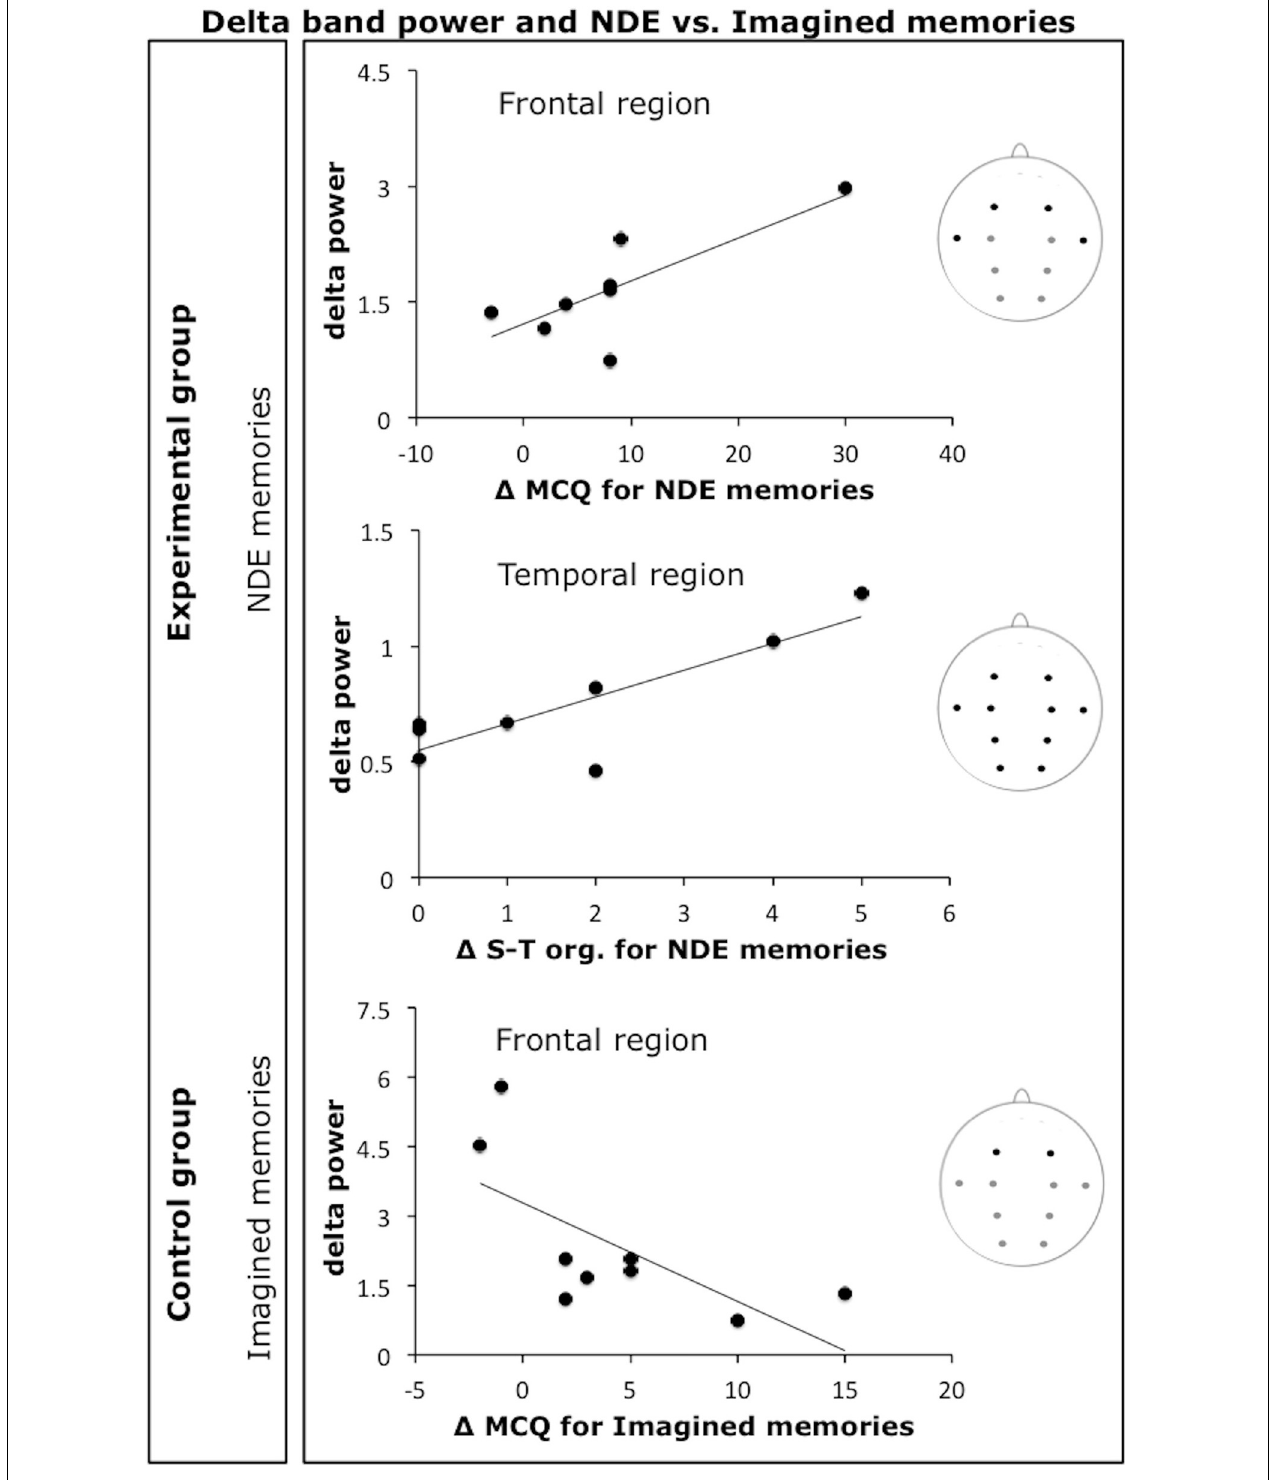
FIGURE 3 | Scatterplots of a subset of observed correlations between delta band and individual (cid:2) MCQ scores or (cid:2) MCQ subscales scores. The first two panels show the correlations with the NDE memories condition